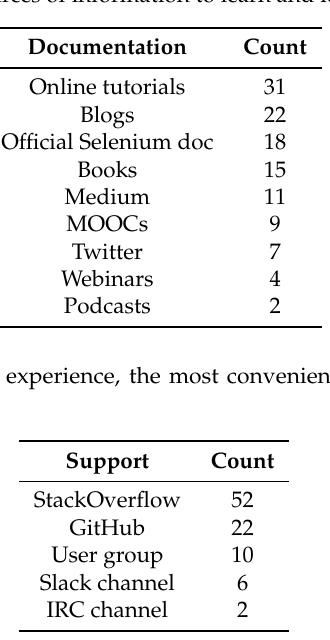
Table A18. 6.a. What are the sources of information to learn and keep updated about Selenium?